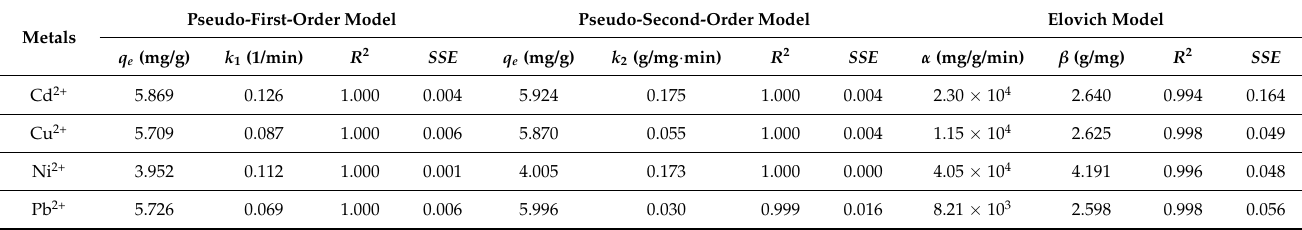
Table 3. Intraparticle diffusion model parameters for heavy metal biosorption on 1 M NaOH- treated H. fusiformis .